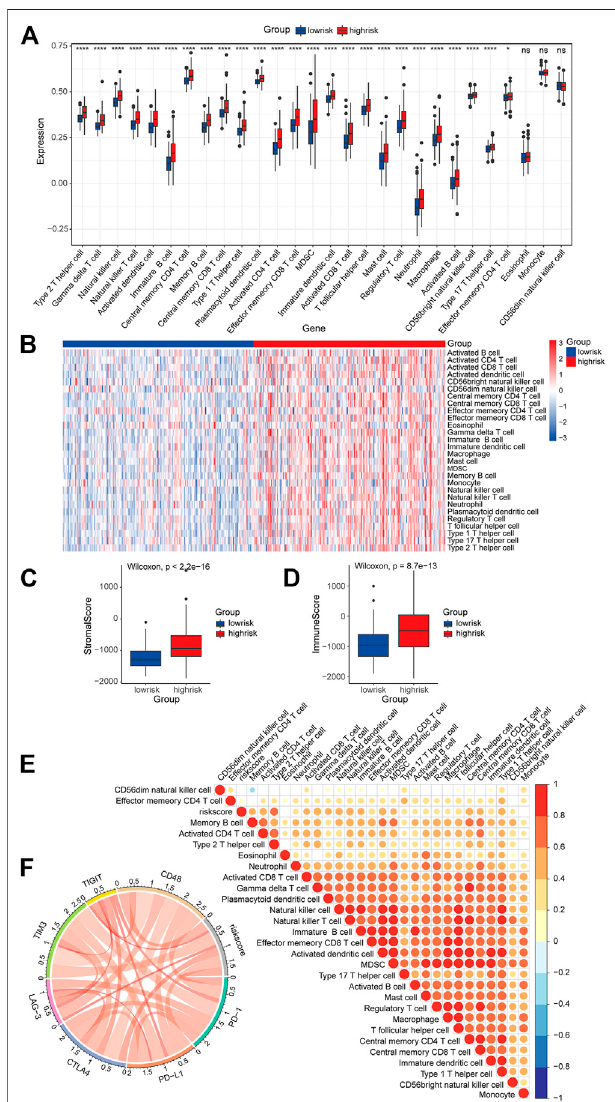
FIGURE10| RoleoftherisksignatureintheTIME. (A) ssGSEAscoresof the 28 immune cells in the high-risk group and the low-risk group (* p < 0.05; **** p < 0.0001; ns, not signi fi cant). (B) Heatmap of the expression of the immune cell markers in the low-risk and the high-risk groups. (C,D) Differencesinoverallimmuneandstromalactivitybetweenthehigh-riskgroup and the low-risk group using the ESTIMATE algorithm. (E) Correlation between the risk signature and 28 TIME cell in fi ltration. (F) Correlation between the risk signature and immune checkpoints.